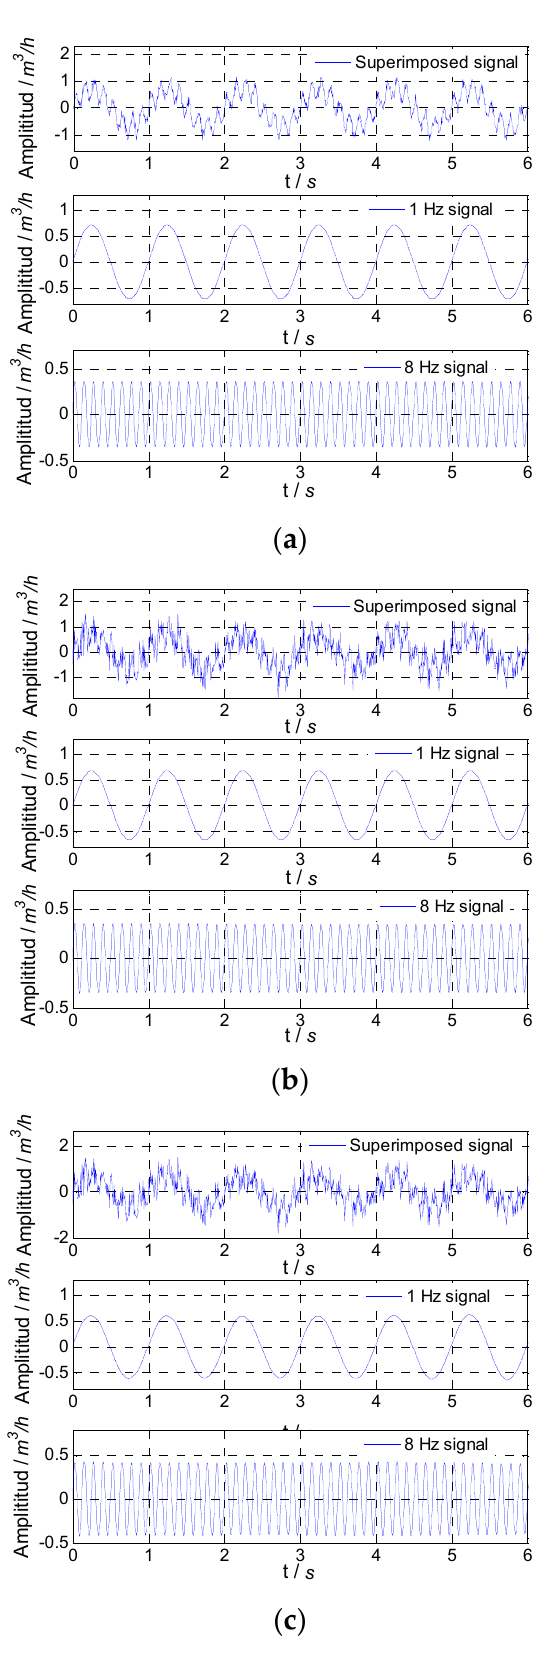
Figure 6. Simulated result for extracted signals: ( a ) noise variance, 0.01; ( b ) noise variance, 0.1; ( c ) noise variance, 1. Table 4. Amplitude attenuation and SNR improvement for extracted signals.